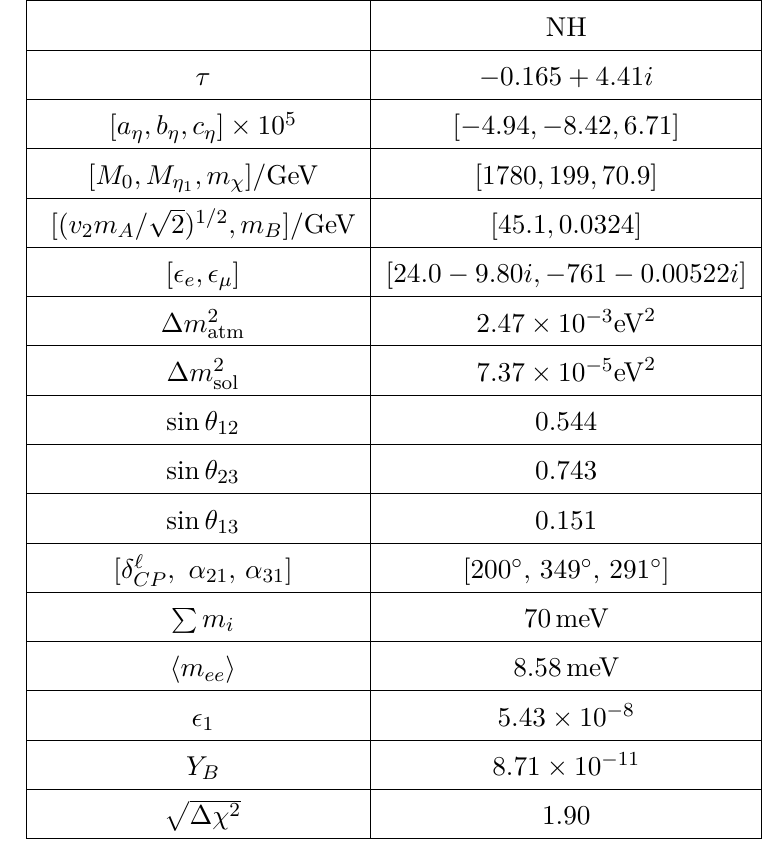
Table 2 . Numerical benchmark point of our input parameters and observables at nearby the fixed point τ = i × ∞ in NH. Here, we take BP so that δ CP is closest to the BF value of 195 ◦ within p ∆ χ 2 ≤ 1